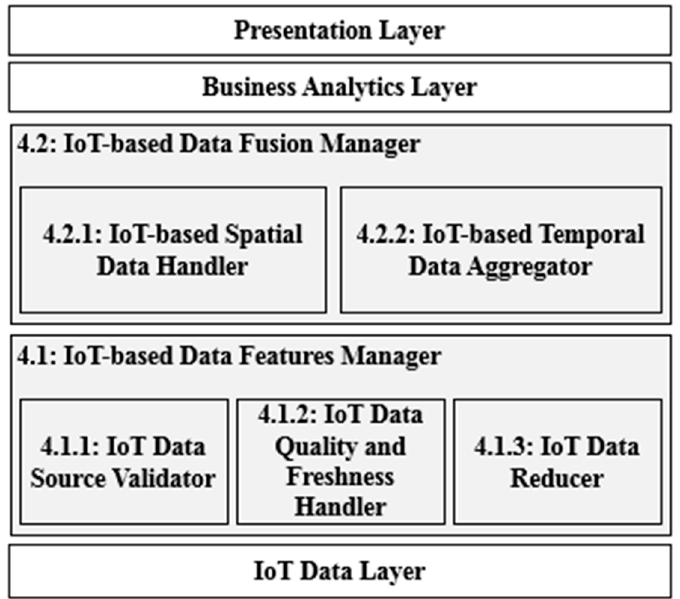
Figure 3. The proposed STDF architecture.